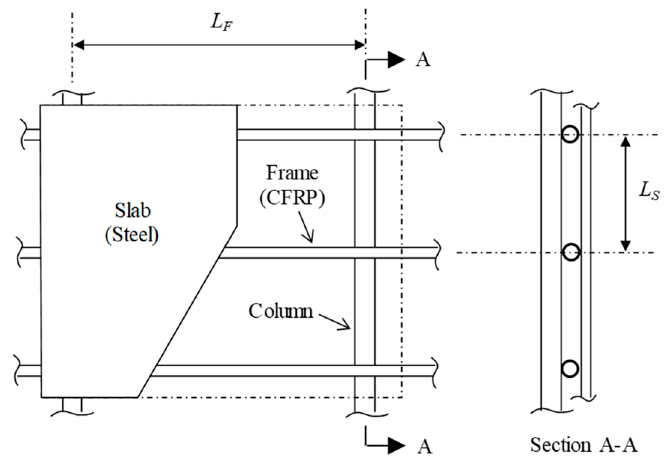
Figure 1. Steel slab and CFRP frame system.